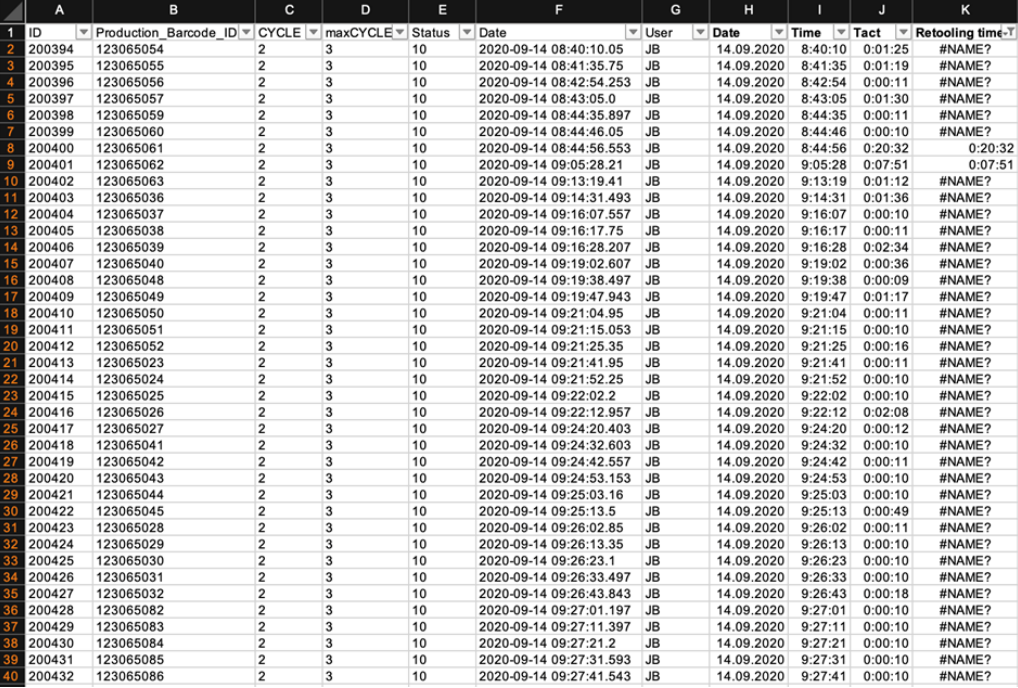
Figure 3. An example of the machine report.